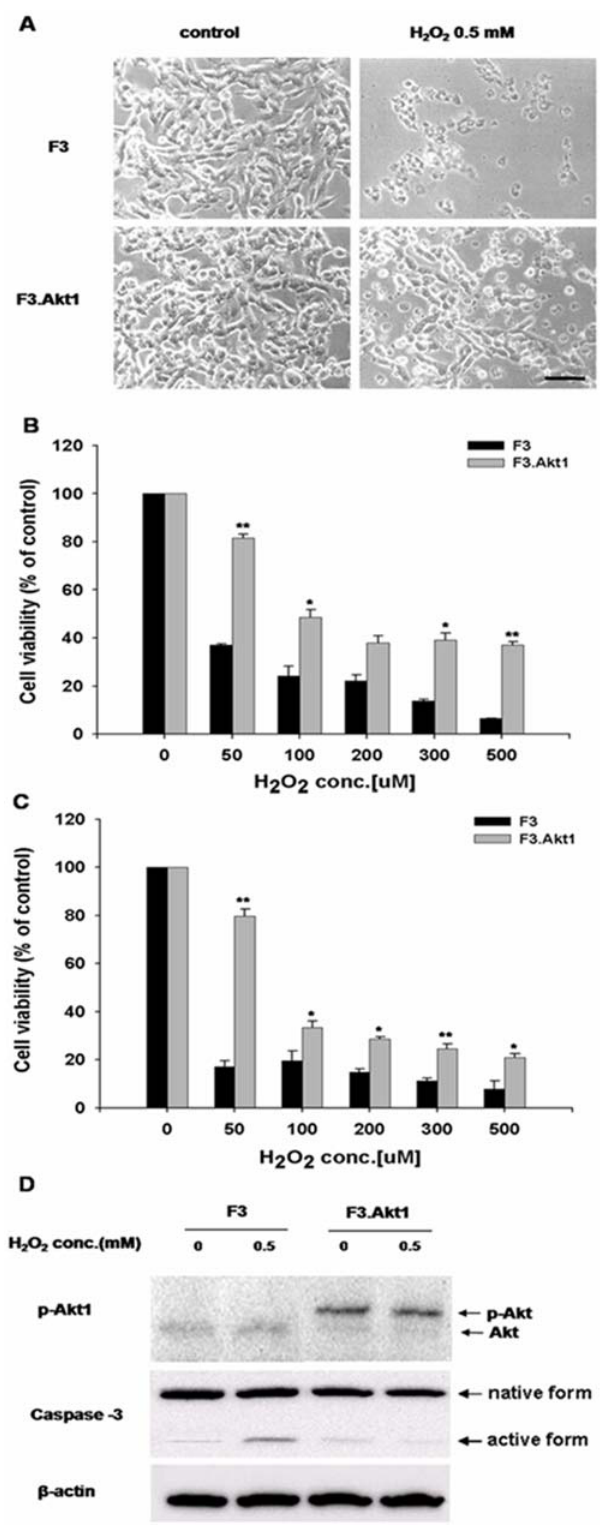
Figure 2. Cell viability increases to H 2 O 2 –induced oxydative stress conditions and Akt1 phosphorylation in F3.Akt1 human NSCs. A: Phase contrast microscopy of F3 and F3.Akt1 human NSCs following exposure to 0.5 mM H 2 O 2 for 6 hr. F3.Akt1 NSCs survived well as compared to the parental F3 NSCs. B and C: F3.Akt1 NSCs were found to show resistance to H 2 O 2 -induced cell death as compared to control